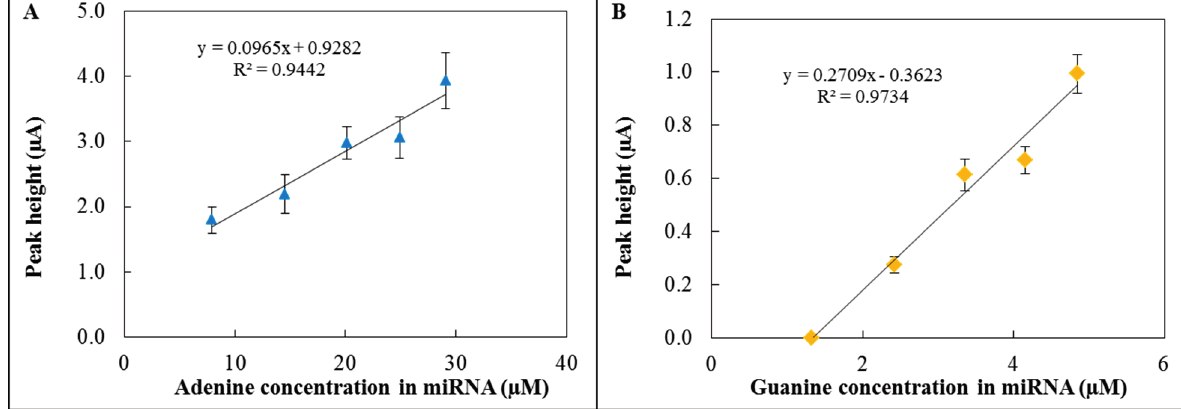
Figure 5. Calibration curves related to the electrochemical detection of ( A ) adenine and ( B ) guanine in hydrolysed miRNA in the microfluidic system; repeated in triplicate. Presented amounts of adenine and guanine are based on miRNA sequence